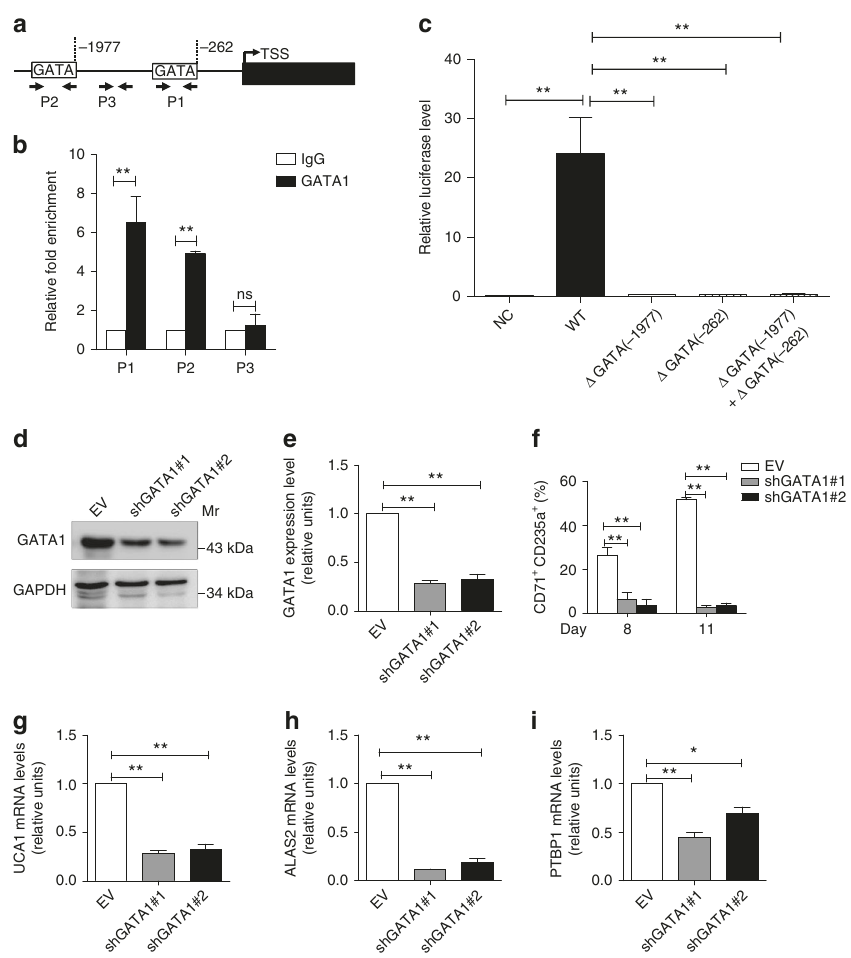
Fig. 7 GATA1 regulates UCA1 expression during erythroid maturation. a Schematic representation of GATA motifs in the UCA1 promoter from -2 kb to the transcription start site (TSS). The white boxes depict GATA motifs, resided in the UCA1 proximal promoter at -262 and -1977 nt 5 ʹ to TSS. P1, P2, and P3 are the primer sets used for ChIP-qPCR assay. b ChIP-qPCR assay analyzed GATA1 occupancy at the UCA1 promoter in primary erythroid cells after 8 days of differentiation. P3 was used as a negative control. c Luciferase report assay demonstrating GATA1 regulates UCA1 promoter transcription in a transient transfection assay. The relative luciferase activity was examined after transfection of empty pGL3 luciferase vector (NC), pGL3 containing the wild-type UCA1 promoter (WT), and pGL3 containing UCA1 promoter with different mutated GATA-binding site(s) ( Δ GATA(-1977), Δ GATA(-262), Δ GATA(-1977) + Δ GATA(-262)) in AraC-induced K562 cells. d , e qRT-PCR ( d ) and immunoblotting ( e ) and analysis of GATA1 expression at day 8 in differentiated primary erythroid cells with or without GATA1 depletion. GAPDH and 18S rRNA were used as controls for WB and qRT-PCR, respectively. f The percentage of CD71 + CD235a + cells evaluated by fl ow-cytometric analysis on days 8 and 11 differentiated primary erythroid cells with or without GATA1 downregulation. g – i qRT-PCR analysis of the relative abundance of UCA1 ( g ), ALAS2 ( h ), and PTBP1 ( i ) mRNA in differentiated primary erythroid cells at day 8 with or without GATA1 depletion. n = 3 independent experiments. Error bars represent SEM. P -values were determined by Student ’ s t -test. *P < 0.05, **P <